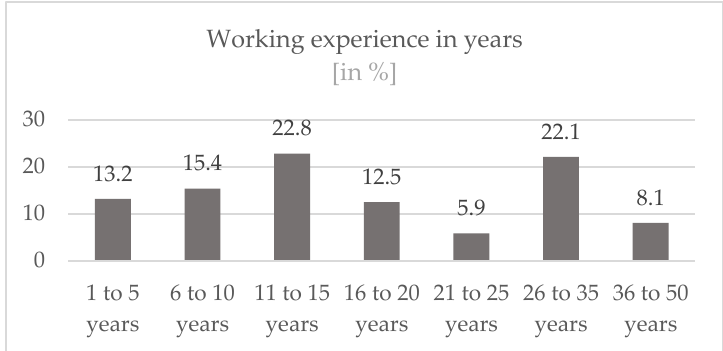
Figure 2. Working experience in years.